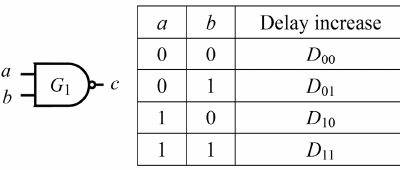
Figure 2. The input vector combination and corresponding delay increase for an NAND gate.